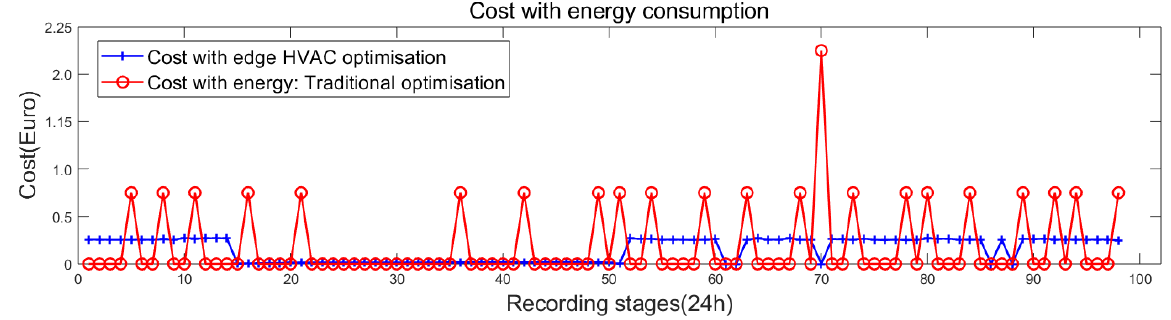
Figure 4. Cost with Thermal Energy Consumption: Manual vs. Edge HVAC optimisation.